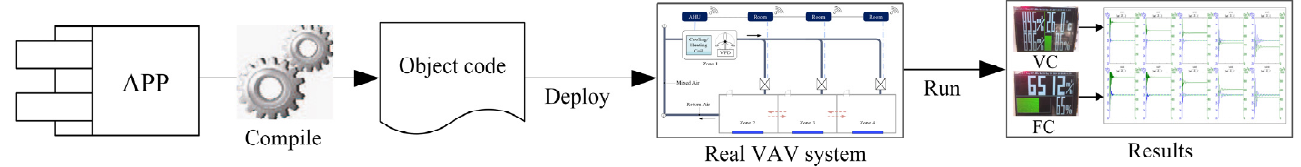
Figure 15. Experimental procedures for SwarmL effectiveness verification.